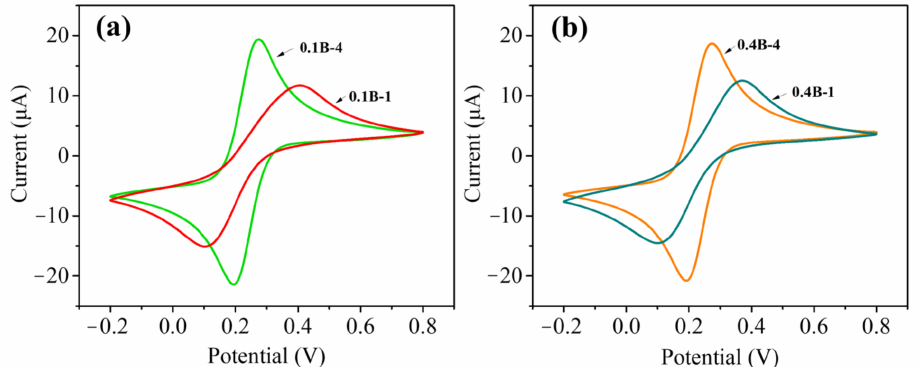
Figure 3. CVs for different BDD electrodes in 1 mM K 3 [Fe(CN) 6 ] with 0.1 M KCl at a scan rate of 50 mv/s: ( a ) 1 h with 0.1 B 2 H 6 and 4 h with 0.1 B 2 H 6 ; ( b ) 1 h with 0.4 B 2 H 6 and 4 h with 0.4 B 2 H 6